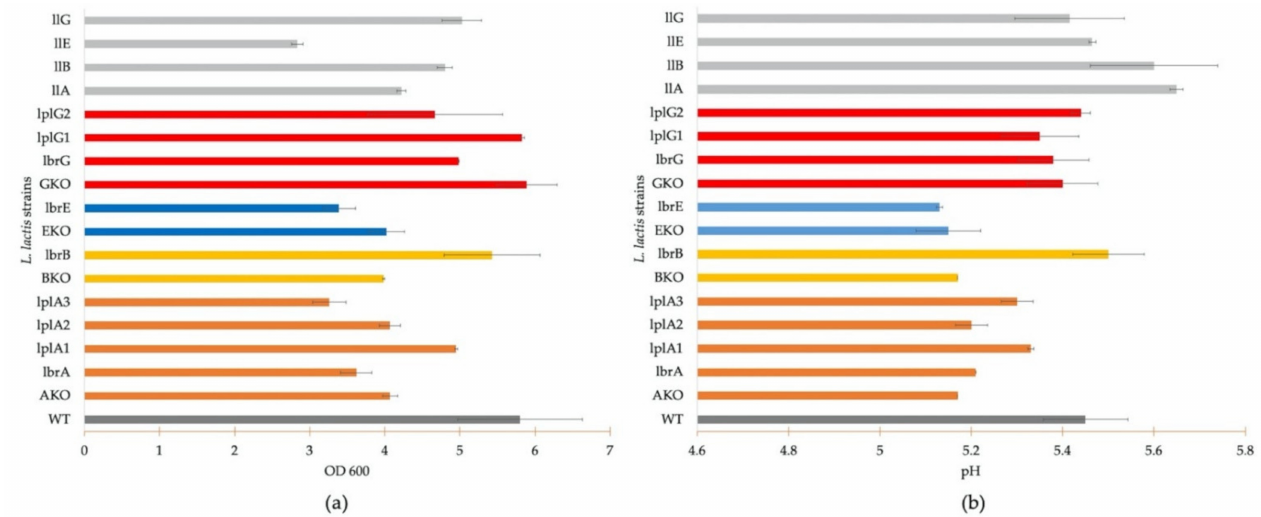
Figure 3. Growth ( a ) and pH profile (at 24 h incubation) ( b ) of L. lactis NZ9000 (WT), its menaquinone deficient strains ( ∆ menA , ∆ menB , ∆ menE , ∆ menG ), L. lactis engineered strains carrying ( lbmenA , lpmenA1 , lpmenA2 , lpmenA3 , lbmenB , lbmenE , lbmenG , lpmenG1 , lpmenG2 ), and engineered deficient strains complemented by homologous genes ( llmenA , llmenB , llmenE , llmenG ). A total of 300 mL of GM17 medium supplemented with heme (2 µ g/mL) was used, and 1 ng/mL of nisin was added as inducer at OD 600 = 0.4. Growth curves are presented in Supplementary Materials Figures